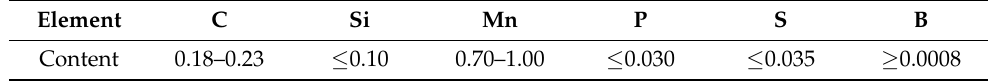
Table 1. The composition of 10B21 steel (wt.%).